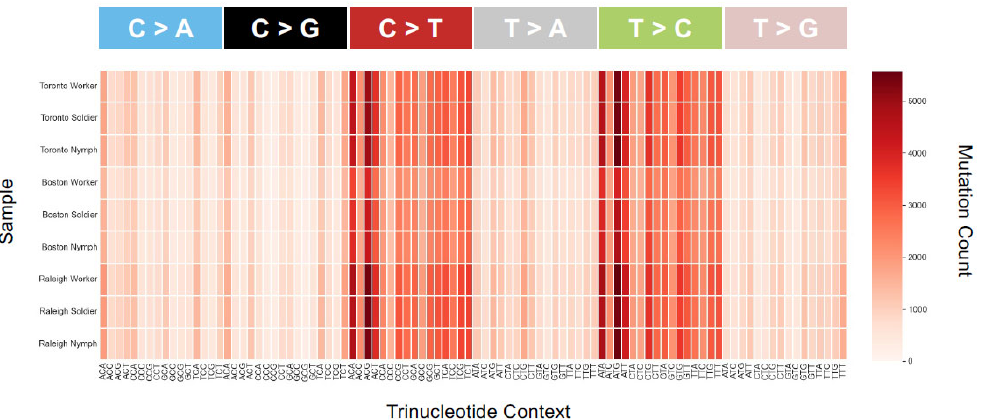
Figure 5. Heatmap of SBS-96 mutation counts for each of the nine samples. All 96 possible mutations are plotted (format available at https://cancer.sanger.ac.uk/cosmic/signatures/SBS, (accessed on 1 November 2021). Most plots show similar biases in mutation types and counts—for example, an excess of transitions across all samples. An SBS-96 plot with purine as a lead base is very similar qualitatively (not shown), consistent with similar mutational mechanisms across populations and castes. There are nonetheless slight differences in the actual numbers of SBSs between caste and population. Additionally, the scale for the Boston population has a smaller range than for Toronto and Raleigh, which is consistent with fewer variants found there (Figure 4B).